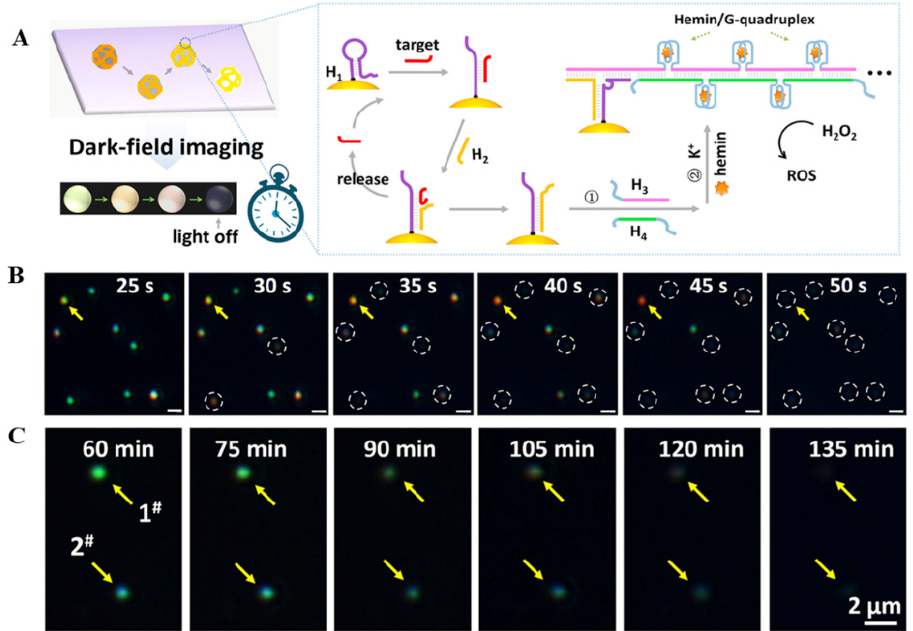
Figure 9. ( A ) DFM sensing principle induced by target recognition and assisted by CHA–HCR amplification. ( B ) DFM images monitored over time while the pretreated concentration of microRNA- 21 was 20 fM. The yellow arrows and cycles mark the points of interest. ( C ) DFM images of two individual plasmonic probes functionalized with hemin/G-quadruplex in DFM detection buffer. The #1 and #2 yellow arrows mark the points of interest. Reprinted with permission from [83]. Copyright 2021 Elsevier.